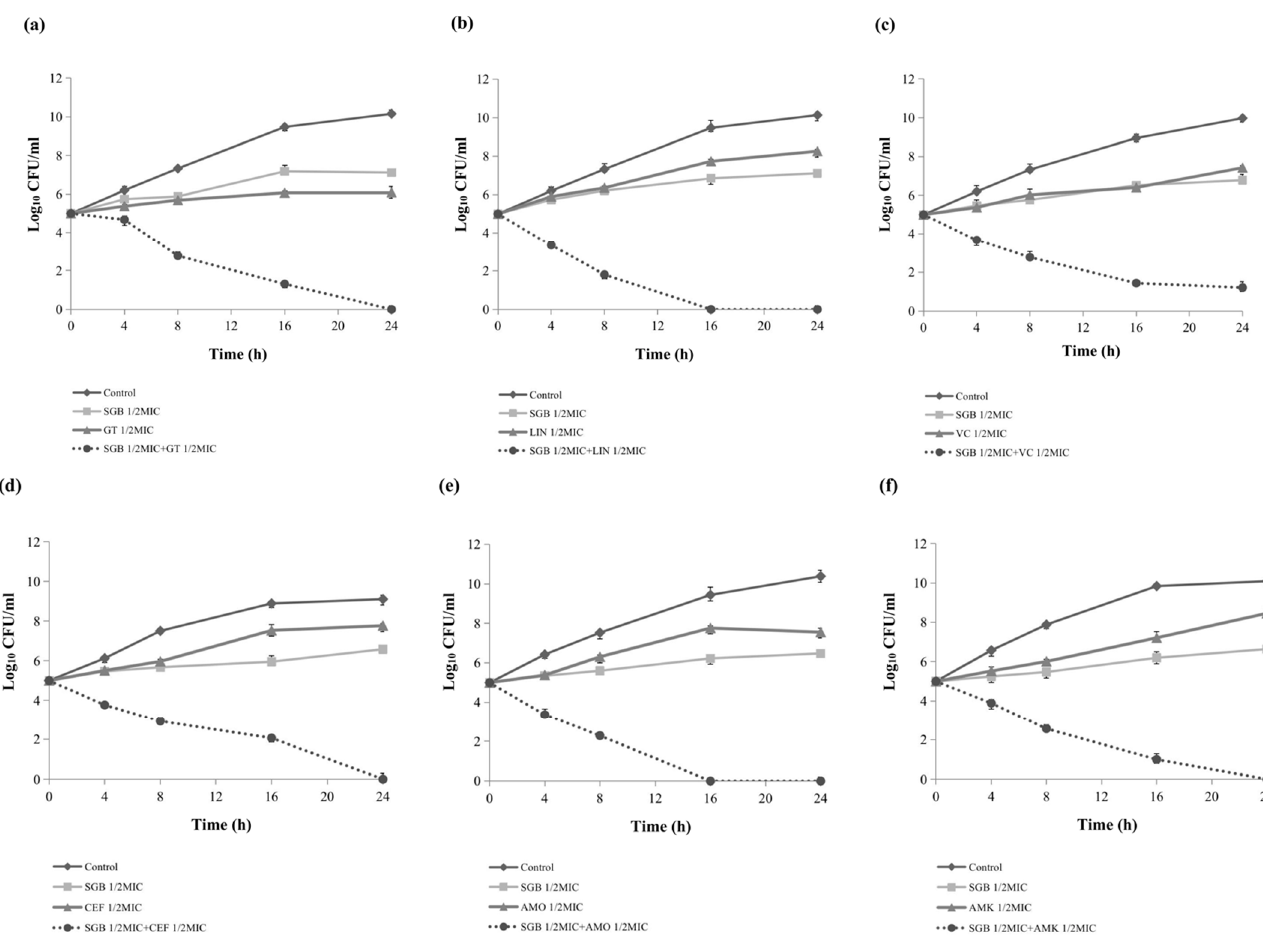
Figure 1. Time-to-kill curves showing synergistic interaction between SGB and conventional antibi- otics against S. aureus ATCC 33591 ( a – c ) and DPS-1 ( d – f ). SGB, sanguisorbigenin; GT, gentamicin; LIN, linezolid; VC, vancomycin, CEF, ceftazidime, AMO, Amoxicillin, AMK, amikacin. Data are the mean ± standard deviation of three independent experiments.